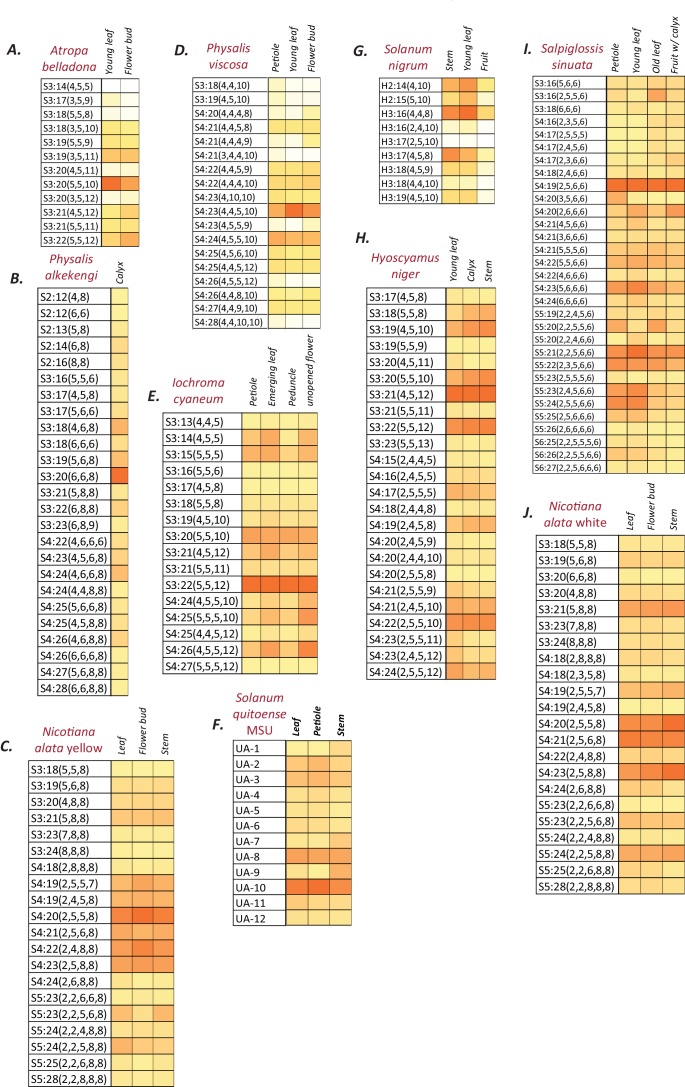
Normalized and integrated acylsugar peak areas in different species.(A–J) Peak area of each acylsugar was normalized using the internal standard peak area and dry weight, and were summed across different isomers of the same acylsugar. Colors represent % normalized peak area of a given acylsugar compared to the total normalized acylsugar peak area in the given tissue. The color scale ranges from no acylsugars (white square) to the species-specific maximum peak area (orange square). The described acylsugars are only a subset of all the detectable acylsugar-like peaks in the plant extract. UA: Unidentified acylsugar, H:Hexose.